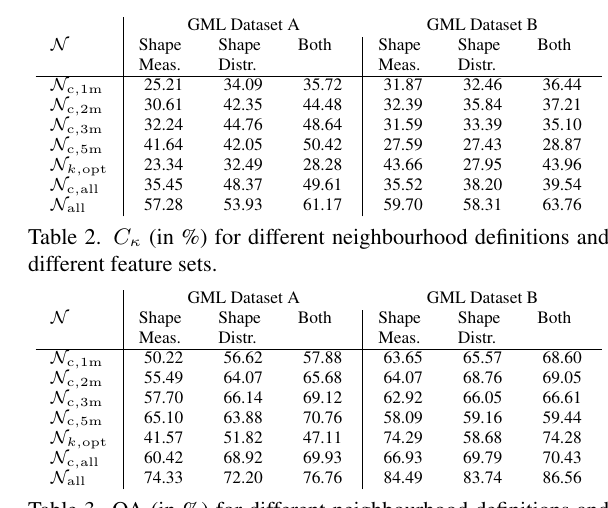
Table 3. OA (in %) for different neighbourhood definitions and different feature